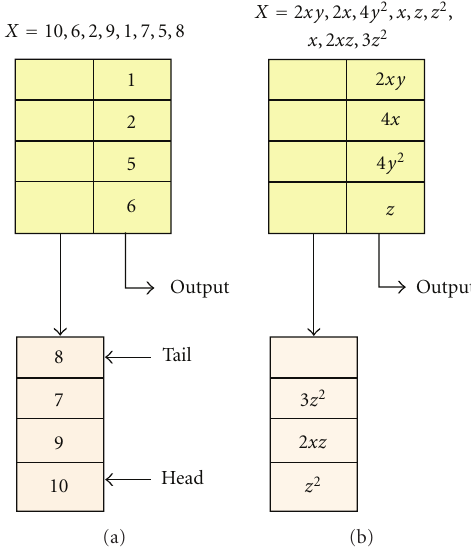
Figure 5: Contents of the systolic array and OF after a first pass of the sequences through (a) sorting and (b) polynomial